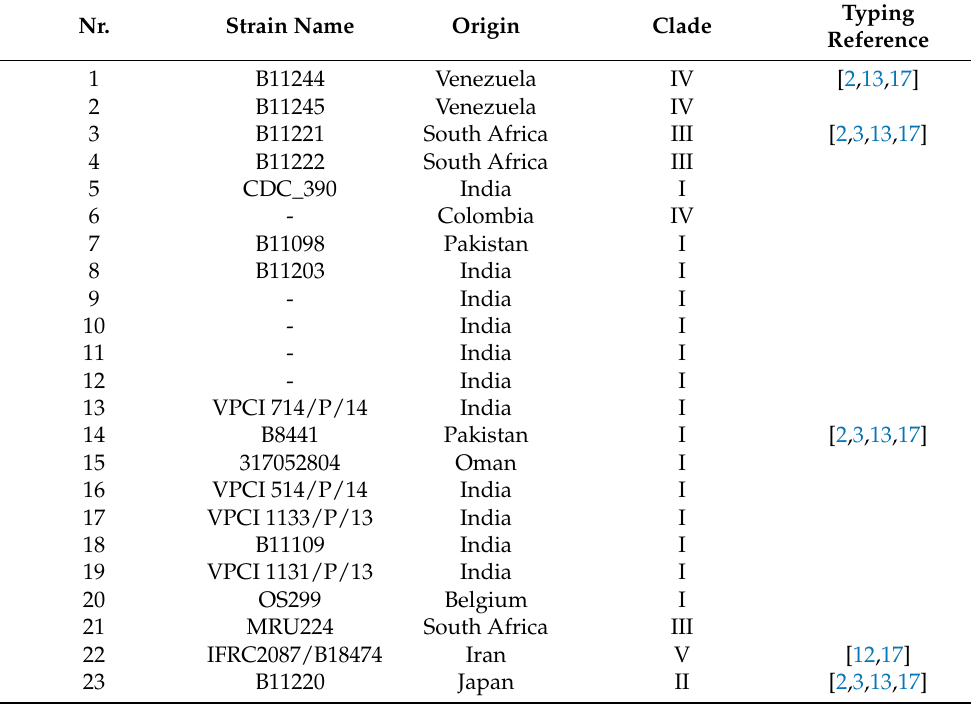
Table A2. All C. auris strains used in this study to validate clade identification AS-PCRs. The strain name (if assigned), origin, clade, and reference to typing literature of the reference strains (bold) are indicated. Clade identification is based on ITS sequencing, microsatellite typing, and/or whole-genome